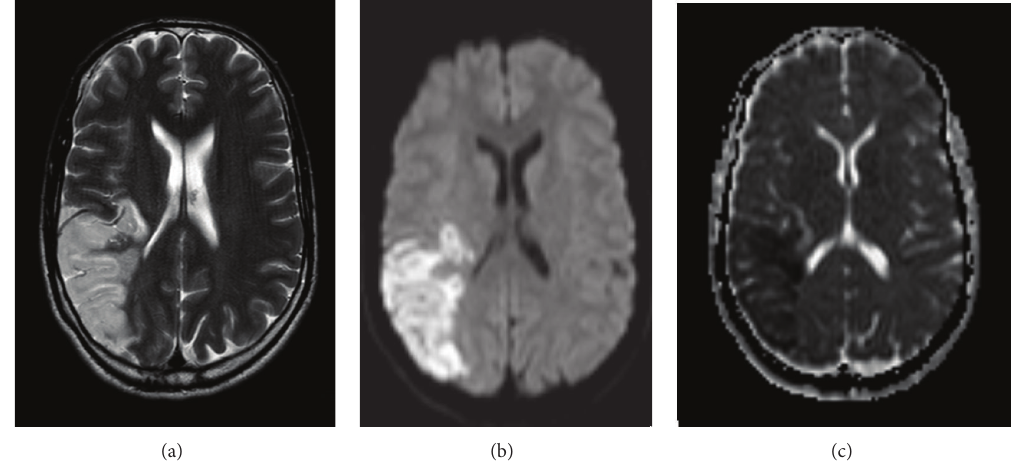
Figure 2: MRI of the brain. (a) T2-weighted image, (b) diffusion weighted image, and (c) apparent diffusion coefficient (ADC) map, showing high signal intensity on the T2-weighted and diffusion weighted image and low signal intensity on the ADC map in the vascular territory of the posterior division of the right middle cerebral artery, consistent with recent ischemia.